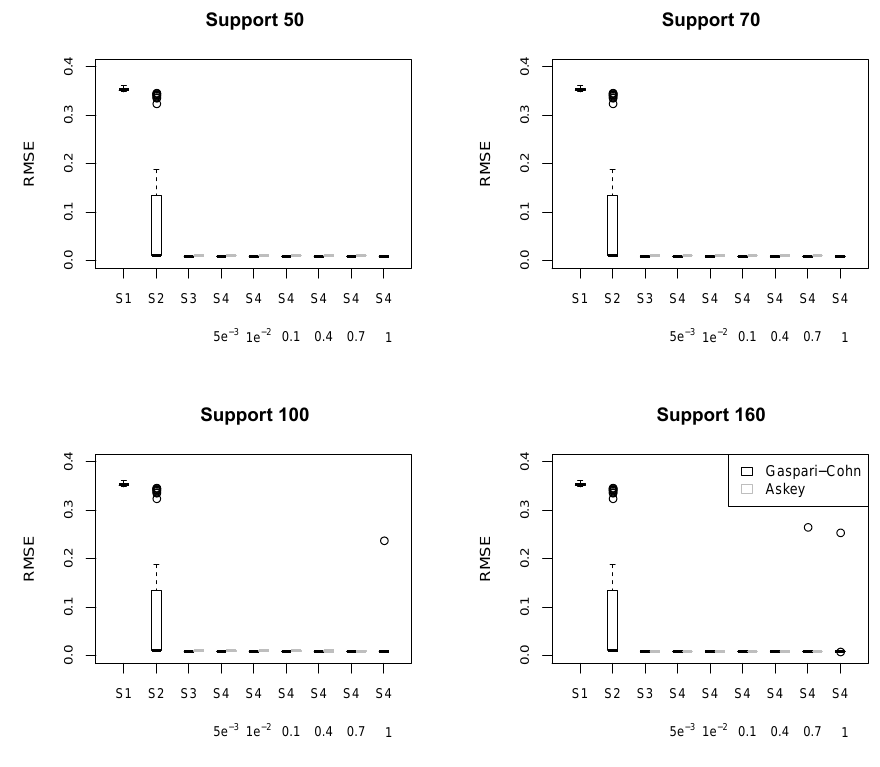
Figure 11. Same as Fig. 7 but for 500 ensemble